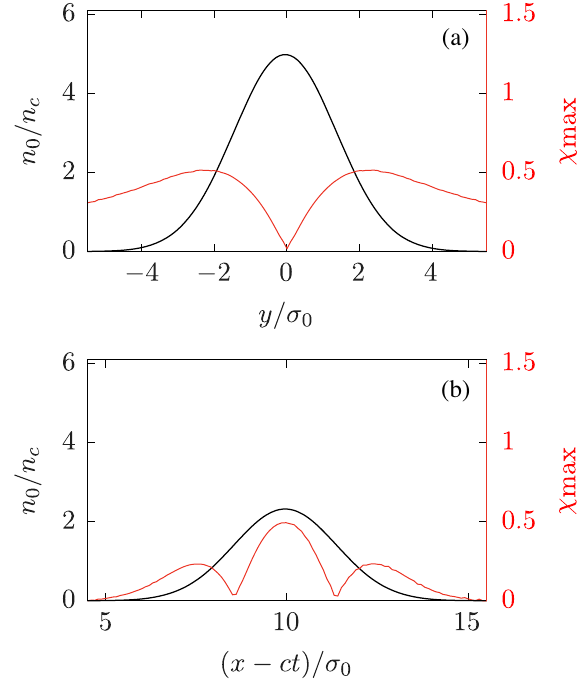
FIG. 7. The 3D PIC simulation result of an electron bunch propagating in a vacuum. Simulations have been performed with the Yee solver, activated radiation reaction force, and disabled Lorentz force at t=T b ¼ 10 . (a) shows the electron density in criticaldensitiesandmaximum quantum parameterwithinacell for a fixed ð x − ct Þ = σ 0 ¼ 20 and z= σ 0 ¼ 0 . (b) shows electron density and χ for a fixed y= σ 0 ¼ 1 . 8 and z= σ 0 ¼ 0 , which slices the max domain through the highest recorded quantum parameter value.